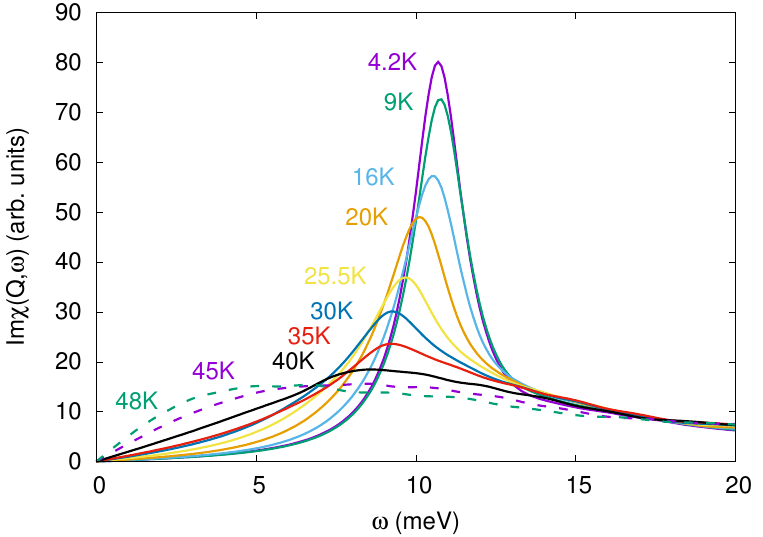
Figure 4. Calculated temperature evolution of the imaginary part of the RPA spin susceptibil- ity for the slightly anisotropic s ± superconductor. Peak positions determine the spin exciton frequency ω R ( T )